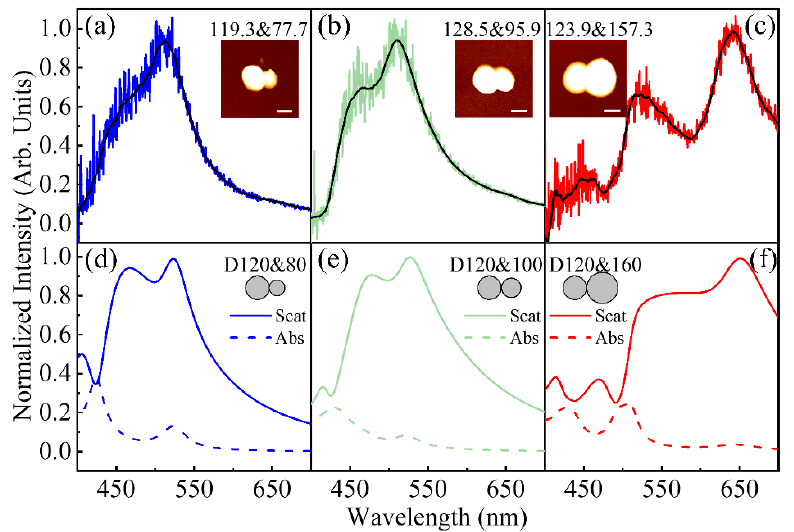
Figure 4. ( a – c ) The experimental dark-field scattering spectra of three silicon dimers. Inset: AFM topographic images of the silicon dimers and corresponding diameters. Scale bar: 100 nm. ( d – f ) The simulated scattering and absorption spectra of the corresponding nanostructures under longitudinal excitation and related dimers in simulation.